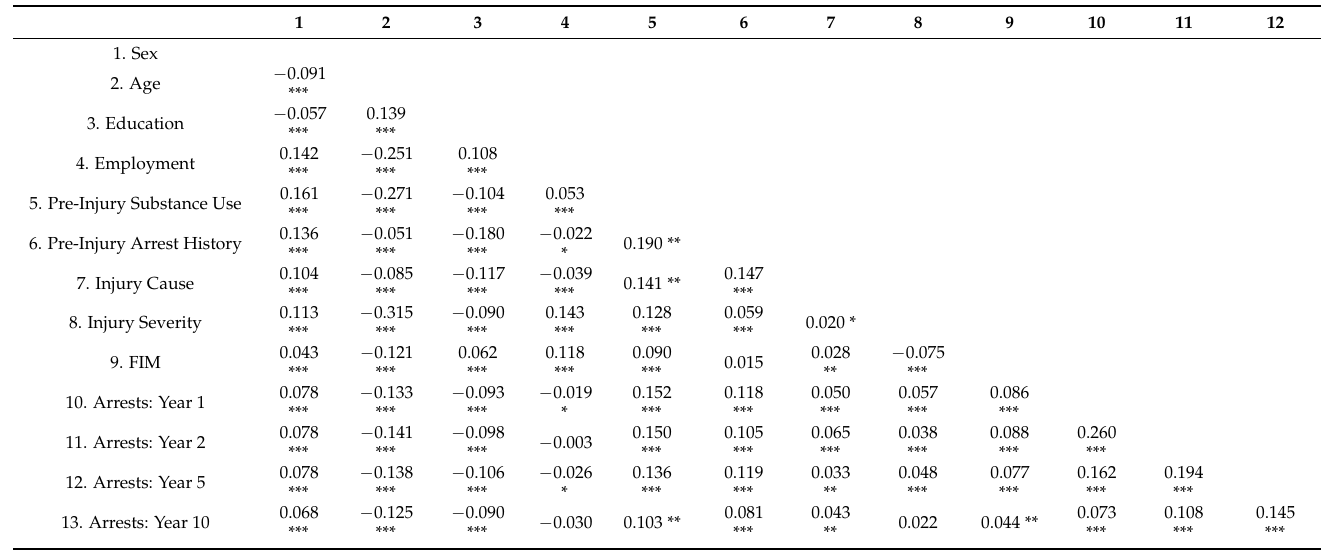
Table 2. Correlation